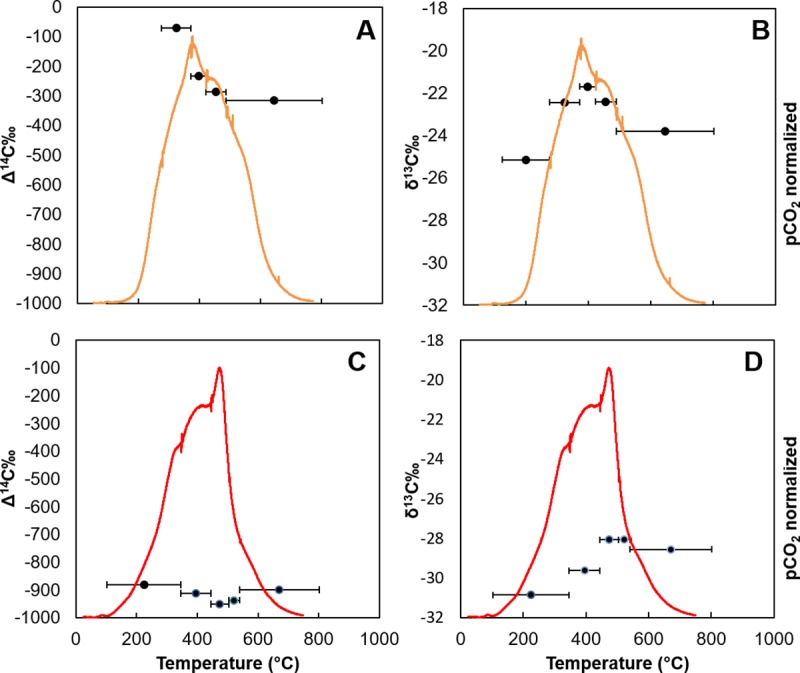
CO2 thermograph and isotopic composition of evolved
CO2.Temperature interval of CO2 fractions indicated by horizontal
bars. A) Control site GB480: Δ14C, B) Control site GB480
δ13C, C) Seep site GC600 Δ14C, D) Seep site
GC600 δ13C.